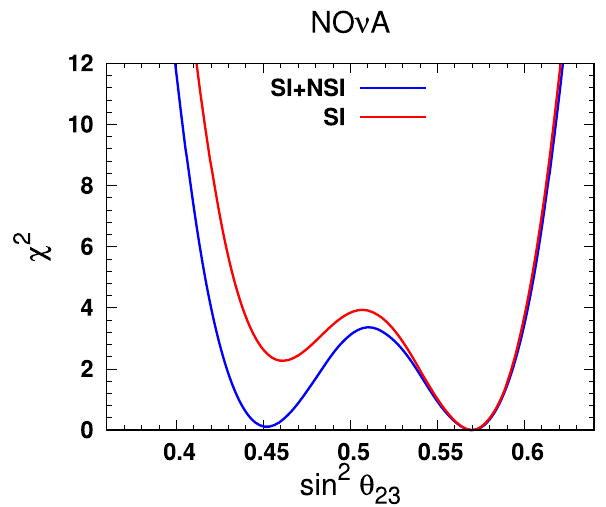
Fig. 6 χ 2 vs sin 2 θ 23 for NOvA obtained assuming both SI (red) and NSI